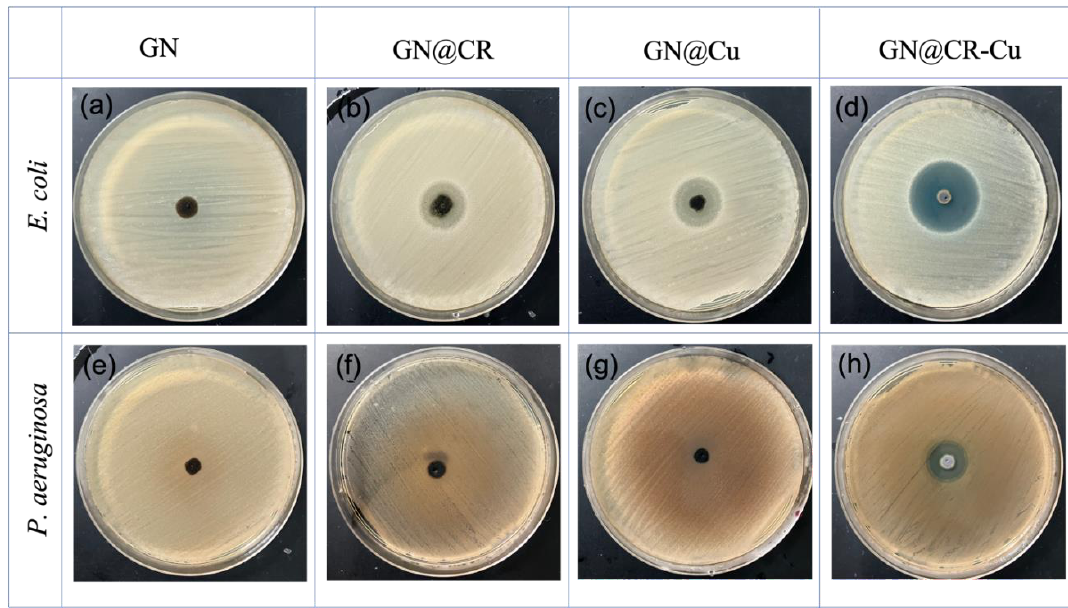
Figure 6. Test bacteria E. coli ( a – d ), P. aeruginosa ( e – h ): The zone inhibition by the nanocomposite material on the bacteria cultivated on nutrient agar media plates.